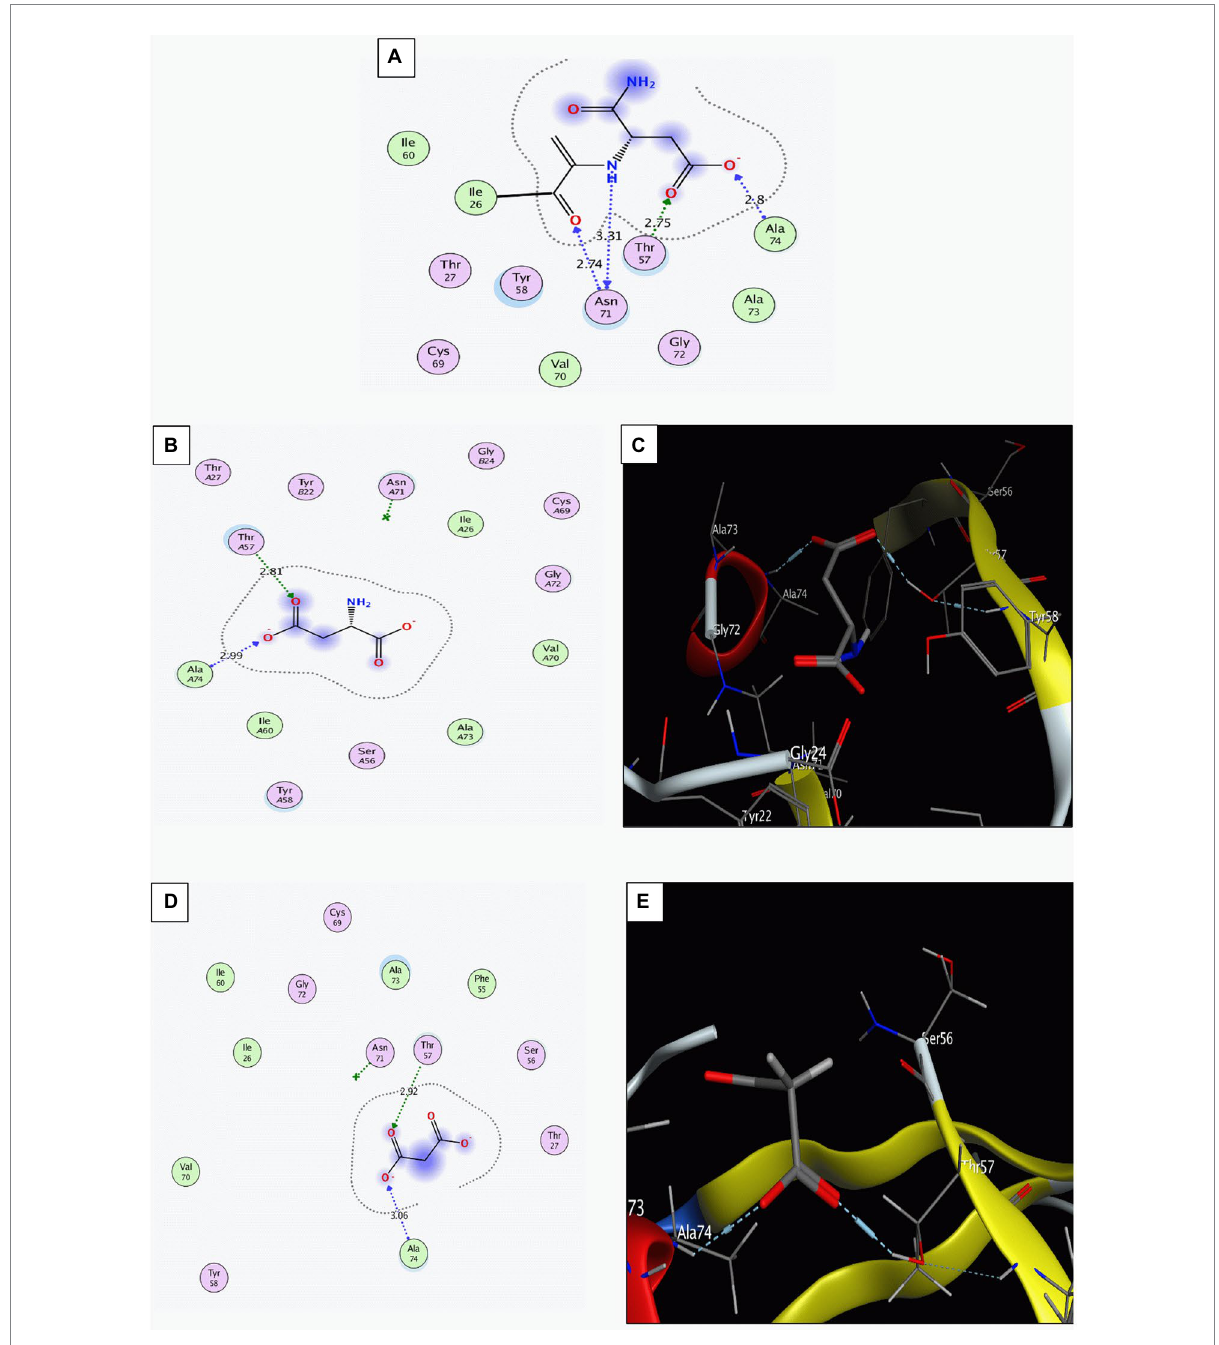
FIGURE 1 Interaction of the binding site of aspartate α -decarboxylase with different ligands. (A) The co-crystalized ligand ((N-2-(2-amino-1-methyl-2- oxoethylidene)asparaginate)). (B,C) Aspartate (Two-D structures and three-D structures). (D,E) Malonate (Two-D structures and three-D structures). Images were generated by Molecular Operating Environment (MOE, 2015.10)